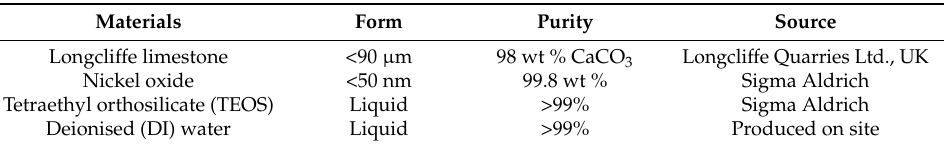
Table 1. Summary of materials utilised.